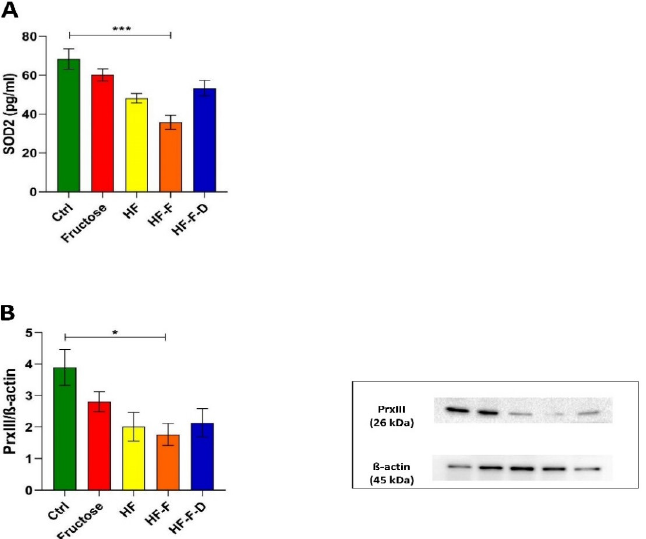
Figure 1. Superoxide dismutase (SOD2) concentration by Enzyme-Linked Immunosorbent Assay (ELISA) ( A ) and Western blot analysis of PrxIII amount ( B ) in liver samples from the Ctrl, Fructose, HF, HF-F, and HF-F-D rats. with each group consisting of four rats. Data were analyzed by Kruskal– Wallis analysis of variance and Dunn’s Multiple Comparison Test (* p < 0.05; *** p < 0.001), each group consisting of four